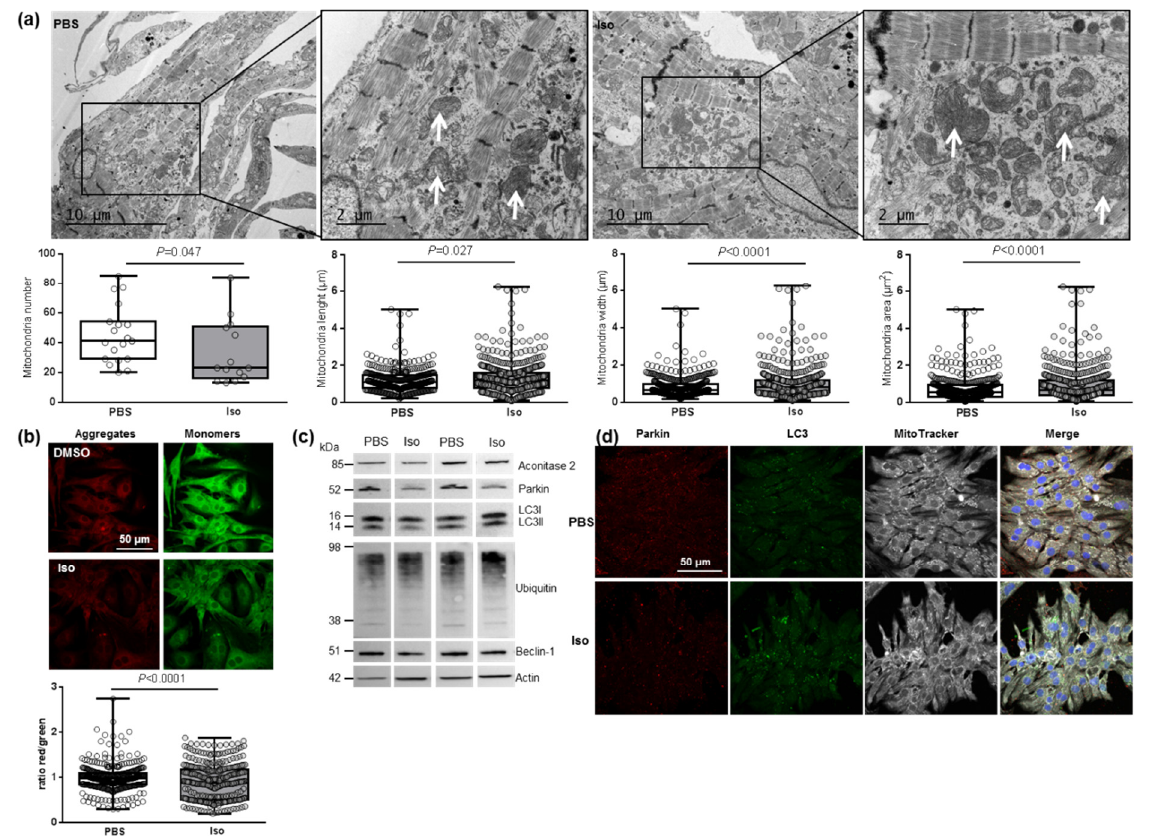
Figure 4. Characterization of mitochondrial function and autophagy/mitophagy in hypertrophied neonatal rat cardiomyocytes (NCMs). ( a ) Ultrastructure of PBS- and Iso-treated NCMs (magnifica- tion ×7000 with a scale bar of 10 µm (left images) and ×12,000 with a scale bar of 2 µm (right imag- es)) and quantification of mitochondria number, length (µm), width (µm) and area (µm 2 ). Arrows indicate example of mitochondria for comparison. ( b ) Mitochondrial membrane potential was quantified in NCMs treated with Iso by fluorescence quantification of JC-1 dye for aggregates (red) and monomer (green) (from 3 independent experiments and at least 366 cells). ( c ) Representative images for quantification of Krebs cycle by Western blot of aconitase 2 and mitophagy/autophagy by Western blot of parkin, LC3II/LC3I ratio, ubiquitin and beclin-1 in NCMs treated with Iso Data were normalized to actin. ( d ) Representative images of parkin (red) and LC3 (green) localized in mitochondria (white) of untreated (PBS) and Iso-treated NCMs. Colocalization appeared in merge images. Nuclei were stained by Dapi (blue). Only significant p values are indicated from at least 3 independent experiments. Images were selected to represent the mean values of each condition. Table 3. Quantification of the mitochondrial biogenesis and autophagy/mitophagy in hypertro- phied neonatal rat cardiomyocytes (NCMs) with or without MitoQ pre-treatment.